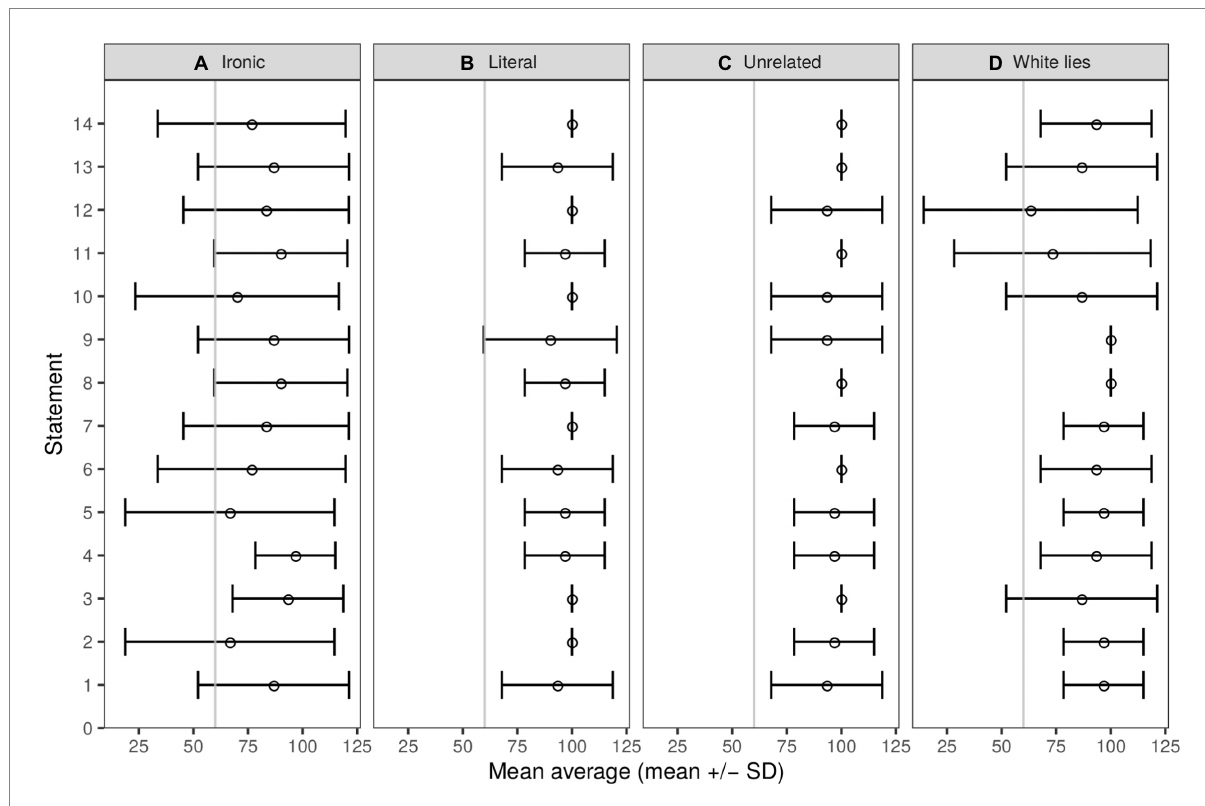
FIGURE 6 Classification accuracy for each statement for Experiment 1 that explored the effect of contextual discrepancy on the identification of irony. Classification accuracy represents the percentage of participants that classified each item accurately (mean + sd), according to its category (A) Ironic, (B) Literal, (C) Unrelated, (D) White lies. The vertical gray line indicates the 65% classification accuracy, which was the minimum for inclusion. All statements met the inclusion